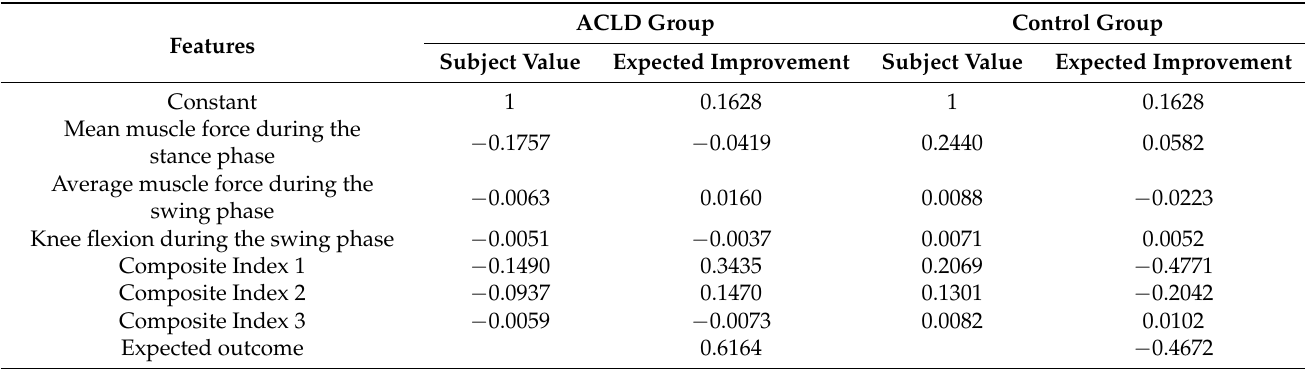
Table 5. Characteristics of two hypothetical subjects from the ACLD and Control